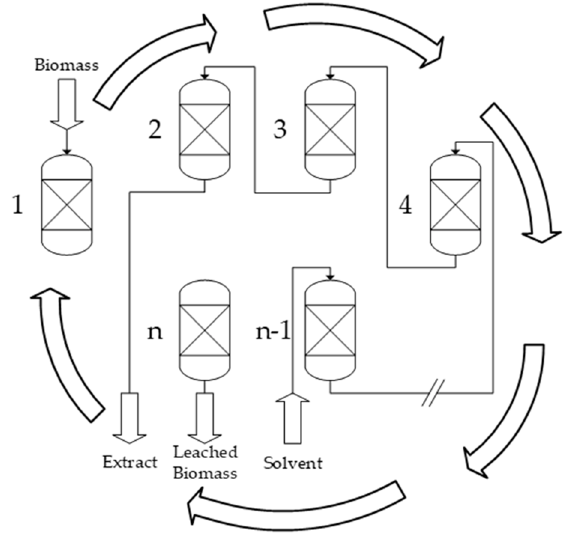
Figure 24. Equivalent flowsheet for a carousel extractor.